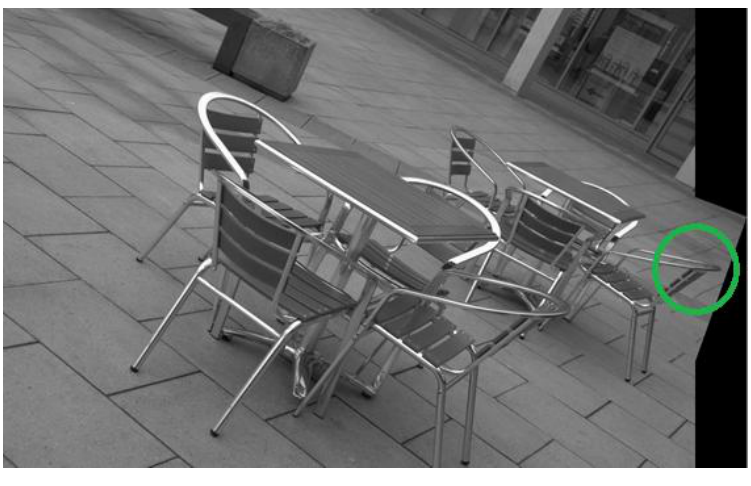
Figure 23. Image registration result for the image pair 12 of the database using the proposed framework; the region inside the green circle shows good